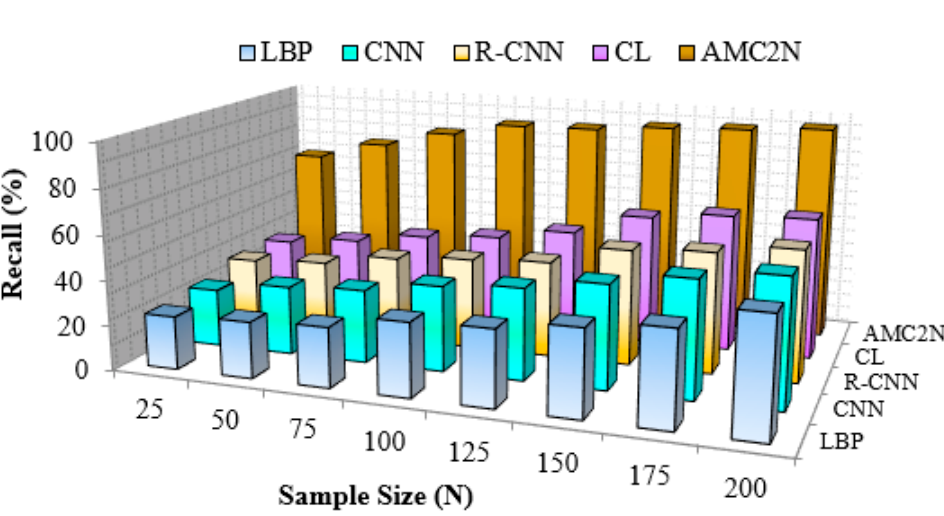
Figure 17. Comparison of F-score (Scenario 1).